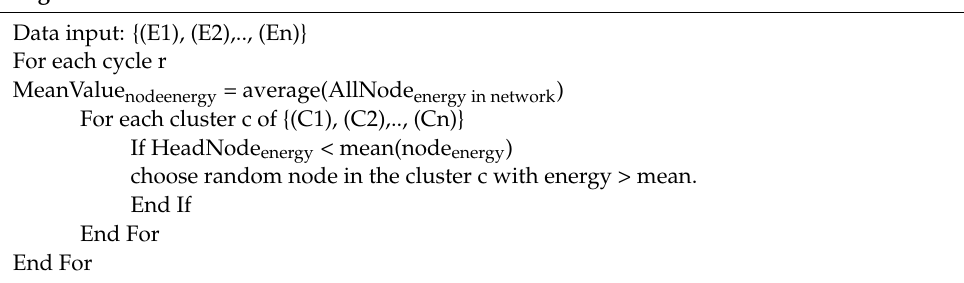
Algorithm 1 : Selection of cluster head: